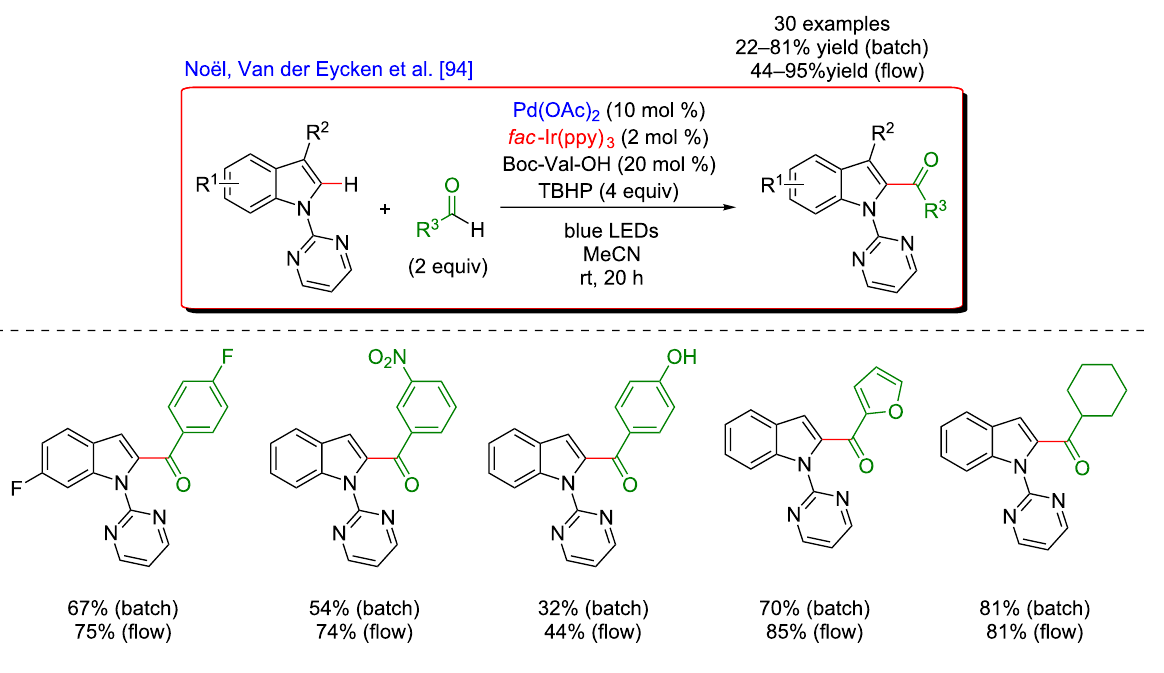
poor aromatic or aliphatic aldehydes were potent coupling part-